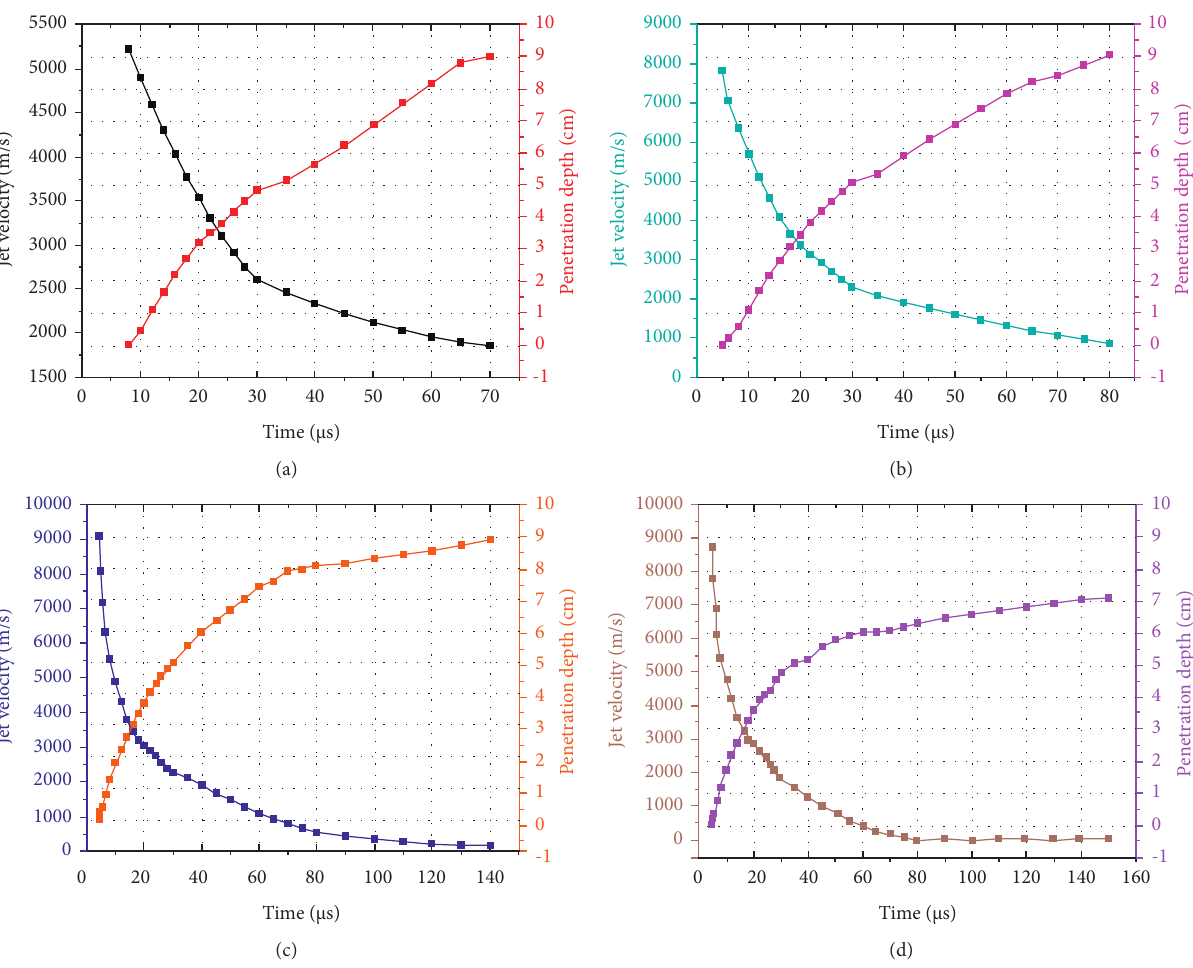
Figure 9: Variation curves of jet tip velocity and target penetration depth during the penetration of micro-jets into gelatin target: (a) copper jet; (b) Teflon jet; (c) nylon jet; and (d) polycarb